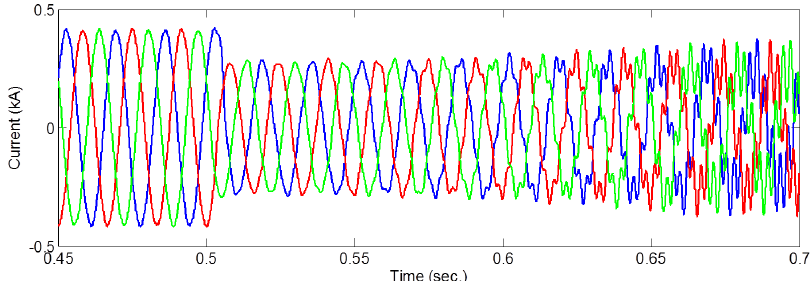
Figure 19. Current waveforms at the point of common coupling (PCC) when CB1 is opened at 0.5 s.